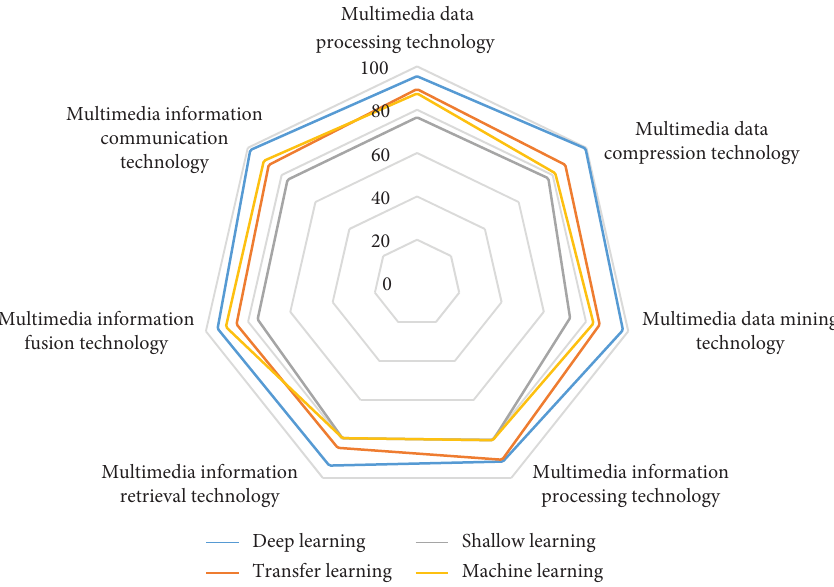
Figure 7: Performance comparison of deep learning in multimedia data